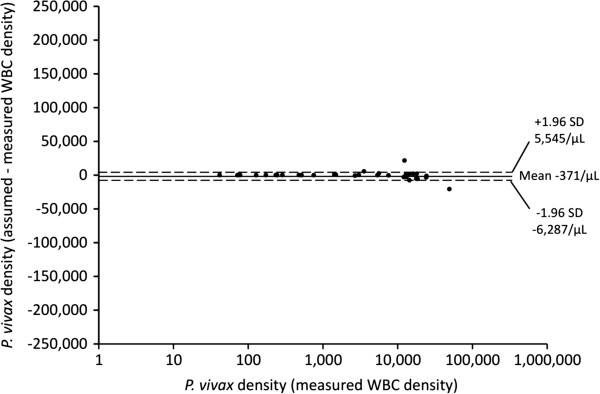
Bland Altman plot showing parasite densities estimated using measured white blood cell densities on a logarithmic scale for Plasmodium vivax cases (abscissa) and the difference in parasite density from assumed and measured leucocyte densities (ordinate axis). The mean difference (solid line) and 95% limits of agreement (dashed lines) are also shown.